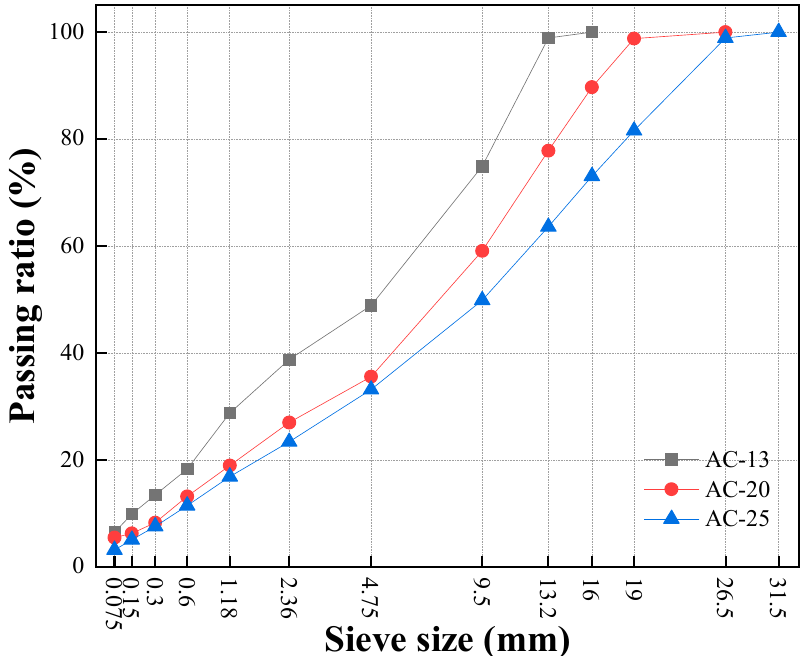
Figure 1. Aggregate gradation curves of the asphalt mixtures.